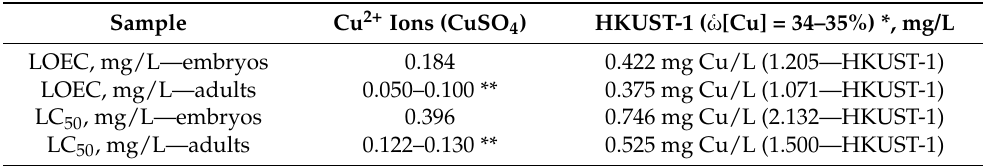
Table 1. Estimated and published LOEC and LC 50 values for copper ions and HKUST-1 * for adult and embryos